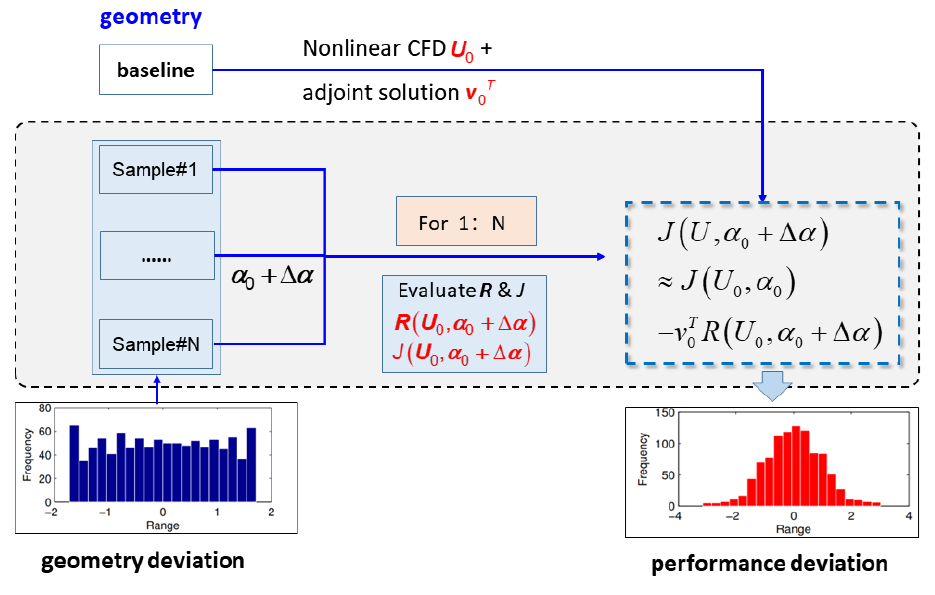
Figure 2. The diagram of the MC − adj − nonlinear method